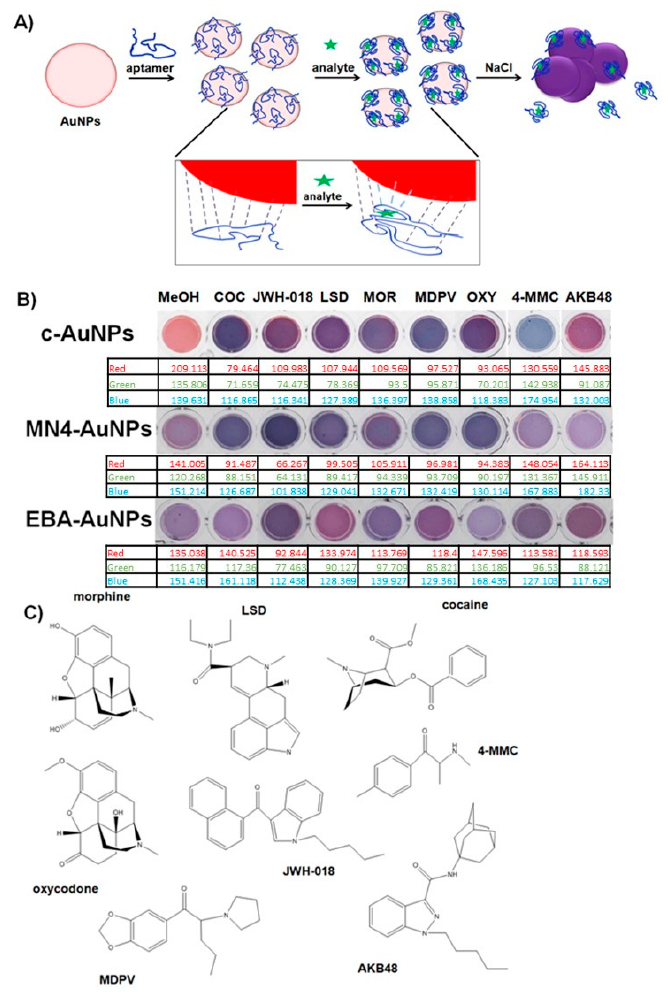
Figure 1. Rationale for controlled substance assay design. ( A ) Schematic representation of the Apt-AuNP conjugates-based plasmonic assay. The inset shows the proposed mechanism of cross-reactive response, in which the interactions between the aptamer, analyte and AuNPs are unique depending on the analyte, resulting in different responses; ( B ) Colorimetric and RGB response obtained with the Apt-AuNPs after exposure to different controlled substances; ( C ) Chemical structures of controlled substances used.